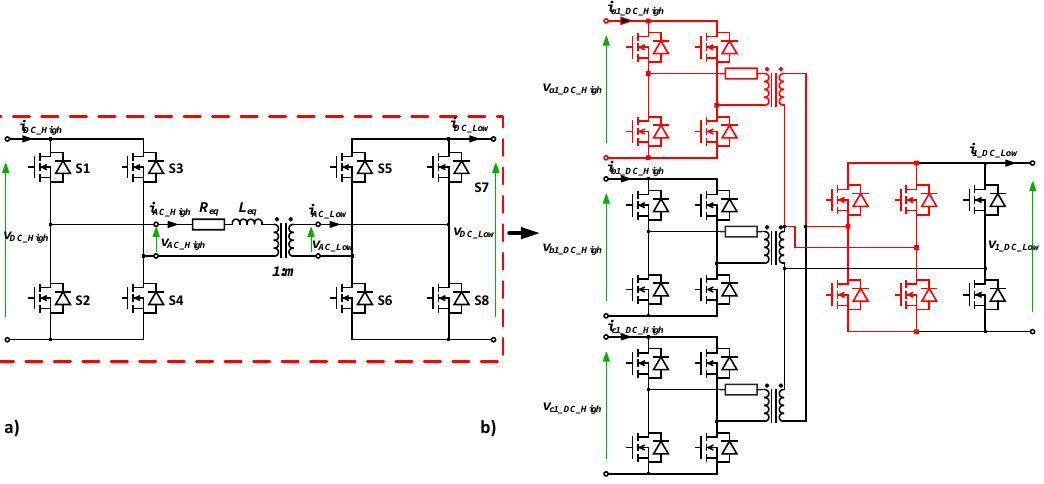
Figure 4. The scheme of the switching model of the proposed single three-phase isolated dual active bridge (DAB), ( a ) the model of the single DAB, ( b ) the model of the implemented multiple active bridge (MAB) structure.